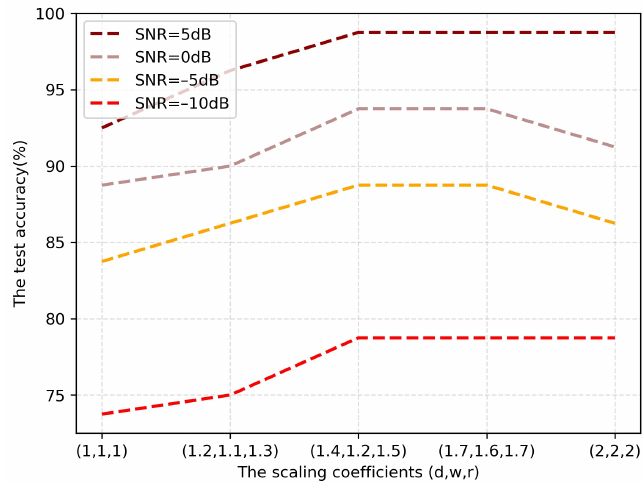
Figure 11. Scaling the model under differenet SNRs with